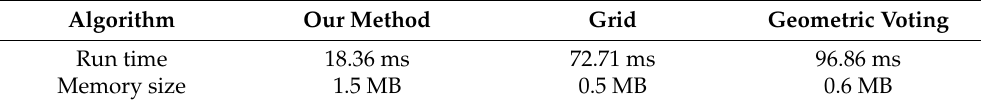
Table 2. Time and memory size.